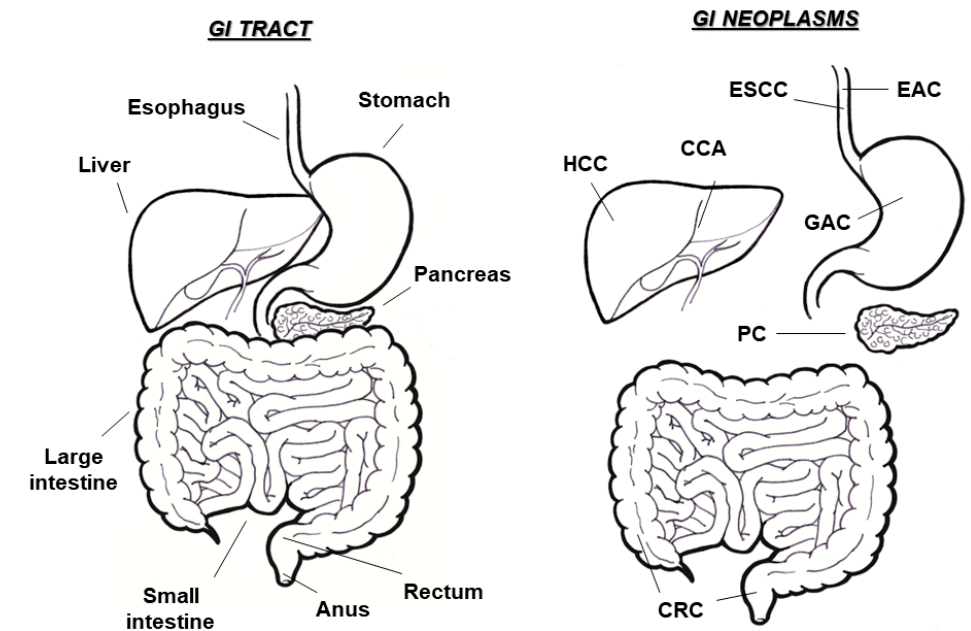
Figure 1. Gastrointestinal (GI) tract and related neoplasms. Schematic representation of the digestive system and overview of main GI cancers, occurring in different anatomic sites (ESCC, esophageal squamous cell carcinoma; EAC, esophageal adenocarcinoma; GAC, gastric adenocarcinoma; CRC, colorectal cancer; HCC hepatocellular carcinoma; CCA, cholangiocarcinoma; PC, pancreatic cancer).